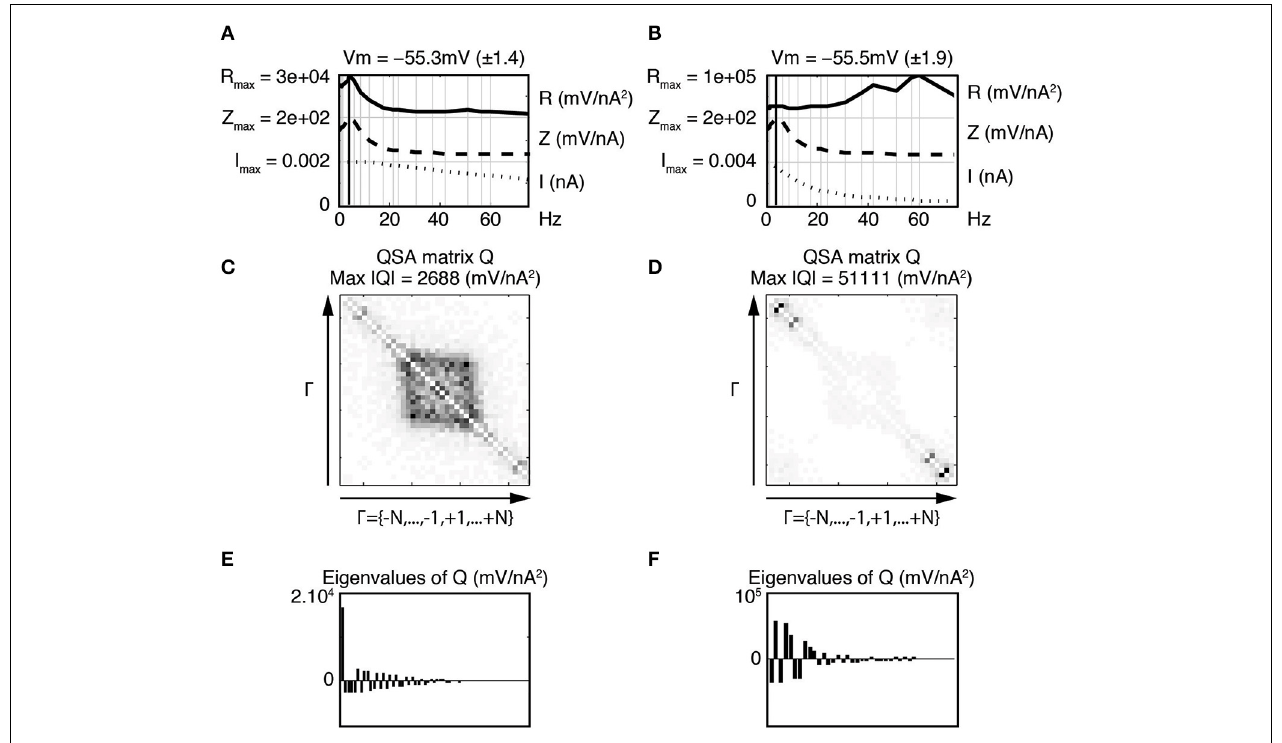
FIGURE 6 | Effect of stimulation profile on stellate neurons. Left column (A,C,E) Weakly low pass filtered stimulation I in dotted lines. Right column (B,D,F) Strongly low pass filtered stimulation I in dotted lines. The resonance of the impedance ( Z ) is f 6 = 4 . 0Hz for both stimulations (A,B) . The